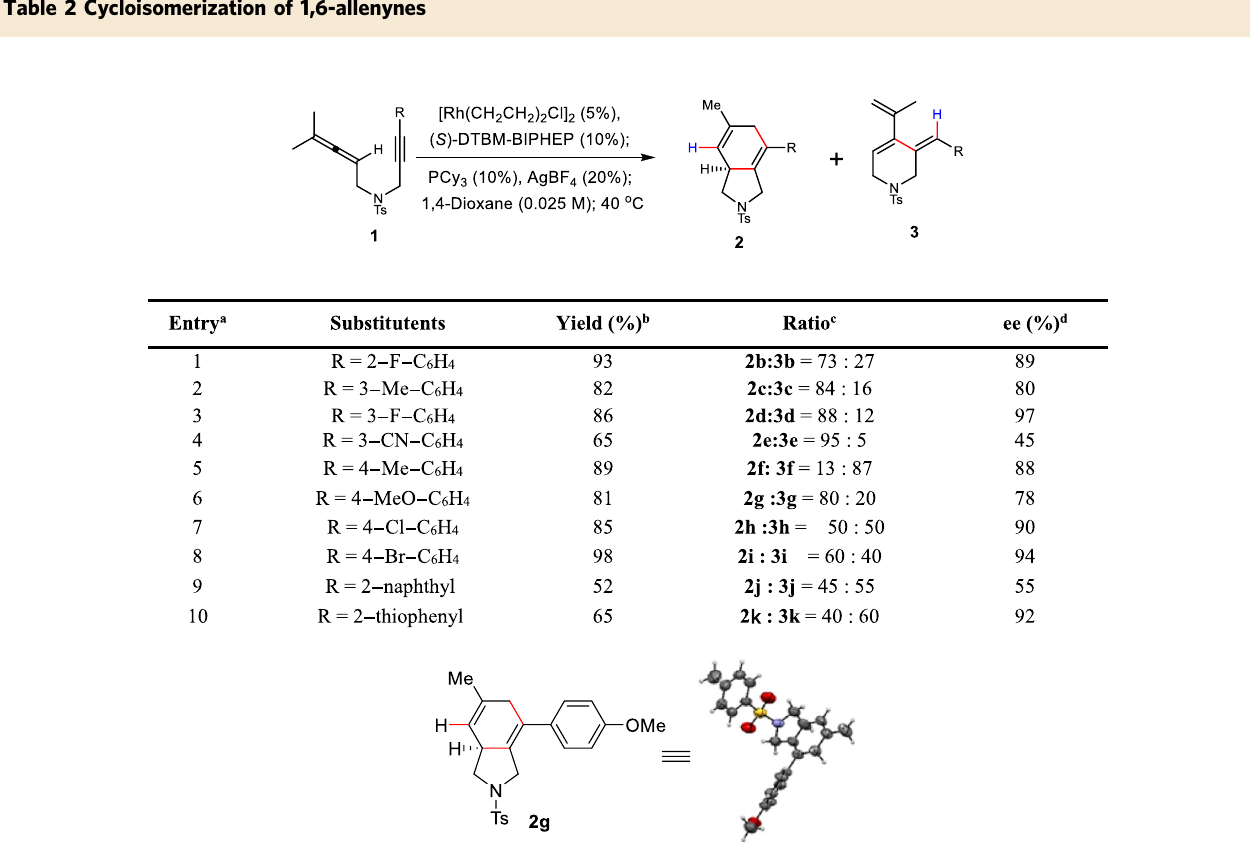
Table 2 Cycloisomerization of